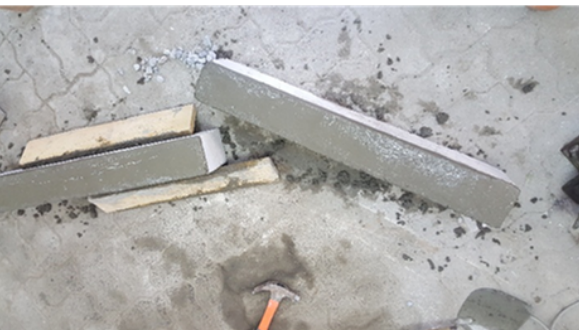
Figure 9: Retrofitted beams.